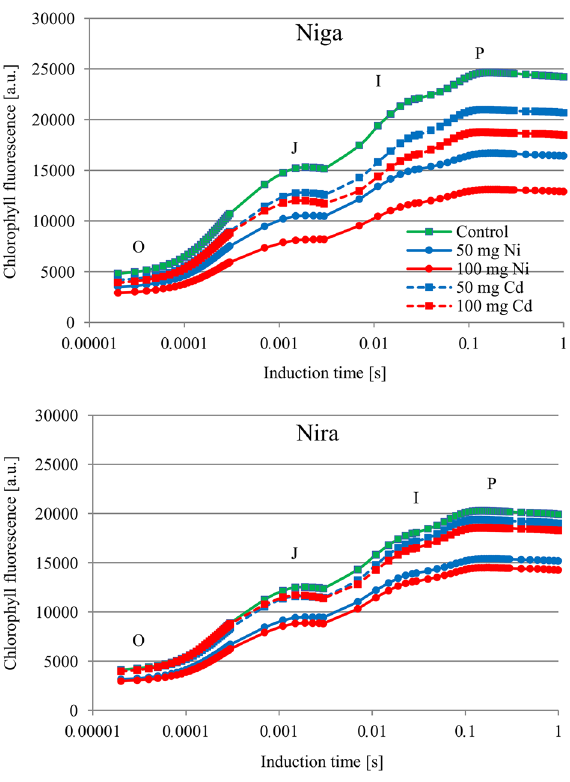
Figure 1. Induction curves of chlorophyll a fluorescence [relative units] of two perennial ryegrass turf cultivars (‘Niga’ and ‘Nira’) under different Ni and Cd treatment (0; 50 and 100 mg × 100 g −1 of substrate) (n =